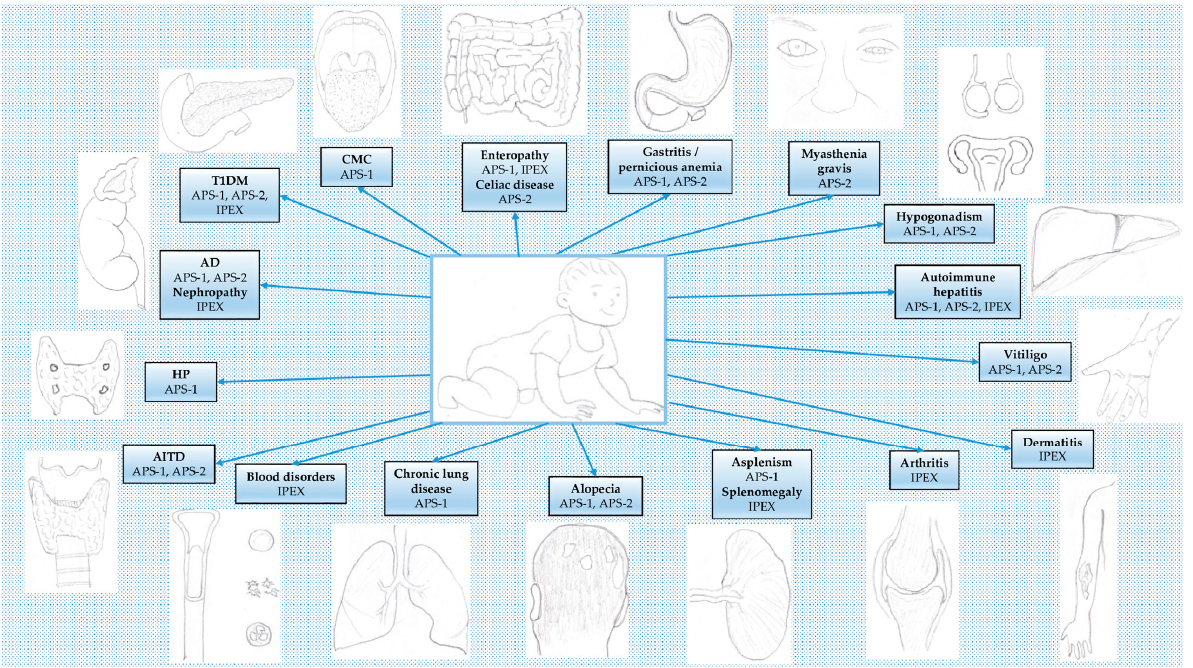
Figure 1. Main manifestations of autoimmune polyendocrine syndromes. Abbreviations: APS, au- toimmune polyglandular syndrome; IPEX, immune dysregulation, polyendocrinopathy, enteropathy, X-linked; CMC, chronic mucocutaneous candidiasis; HP, hypoparathyroidism; AD, Addison disease; T1DM, type 1 diabetes mellitus; AITD, autoimmune thyroid disease. Table 1. Features of autoimmune polyglandular syndromes.